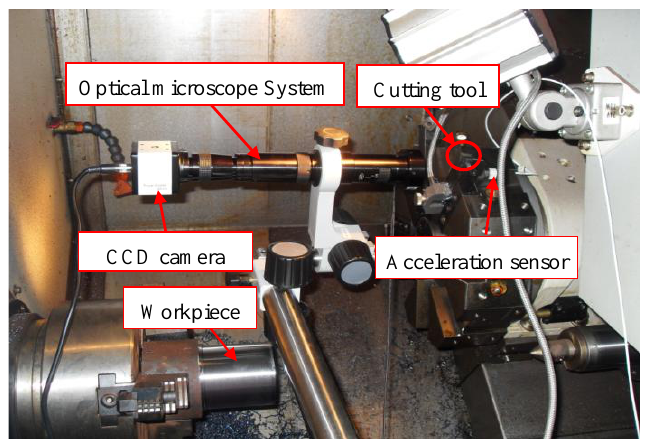
Figure 3. Experimental system and sensor locations.